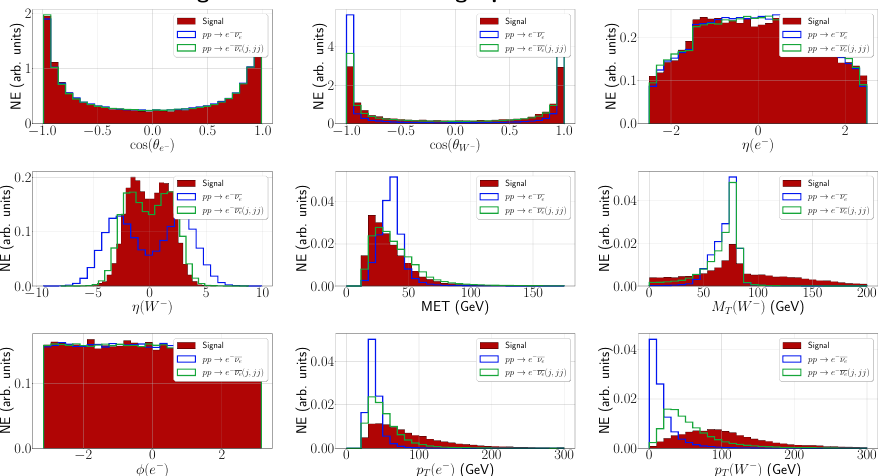
Figure 13. Set of angular and kinematic observables for VLL single-production via the VLBSM topology with a mass m E = 200 GeV. All histograms are normalized, with each having 30 bins. 2 Signal distributions are filled and shown in red, while background distributions are unfilled and shown in blue ( pp → e − ¯ ν e ) and green ( pp → e − ¯ ν e + ( j, jj ) ). From top-left to bottom-right, we have distributions for cosine of the angle for particles e − and W − ; pseudo-rapidity for e − and W − ; MET; transverse mass of the W − boson, azimuthal angle for e − and transverse momentum for e − and W −